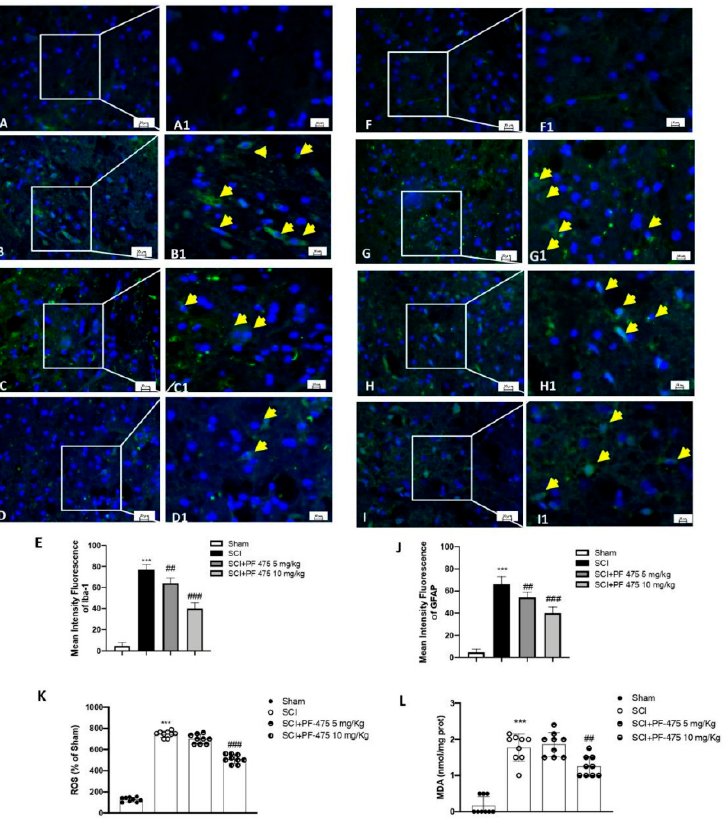
Figure 4. Immunofluorescence analysis of Iba1 and GFAP after SCI. Spinal cord sections were stained with antibodies against Iba1 (green) or GFAP (green) and DAPI to highlight cell nuclei (blue). Sham group (( A , A1 ); see mean of intensity fluorescence ( E )). Iba1 + cells in mice subjected to SCI (( B , B1 ); see mean of intensity fluorescence ( E )). Mice treated with PF-475 at doses of 5 mg/kg (( C , C1 ); see mean of intensity fluorescence ( E )) and 10 mg/kg (( D , D1 ); see mean of intensity fluorescence ( E )). No GFAP + cells showed in. Sham group (( F , F1 ); see mean of intensity fluorescence ( J )). High number of GFAP + cells in SCI group (( G , G1 ); see mean of intensity fluorescence ( J )). PF-475 treatment at a dose of 5 mg/kg (( H , H1 ); see mean of intensity fluorescence ( J )) decrease GFAP+ cells number. PF-475 treatment at a dose of 5 mg/kg (( I , I1 ); see mean of intensity fluorescence ( J )). The content of ROS in spinal cord tissues. ( K ) The concentrations of MDA in spinal cord tissues ( L ). Each data is expressed as SD from ten mice for each group. One-way ANOVA followed by Bonferroni post-test. *** p < 0.001 vs. sham and ## p < 0.01 and ### p < 0.001 vs.